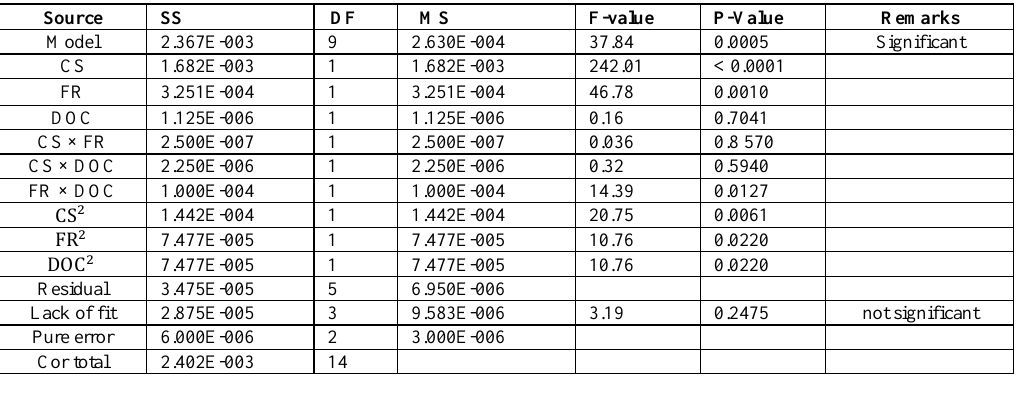
Table 7. ANOVA Table for tool flank wear (V b )